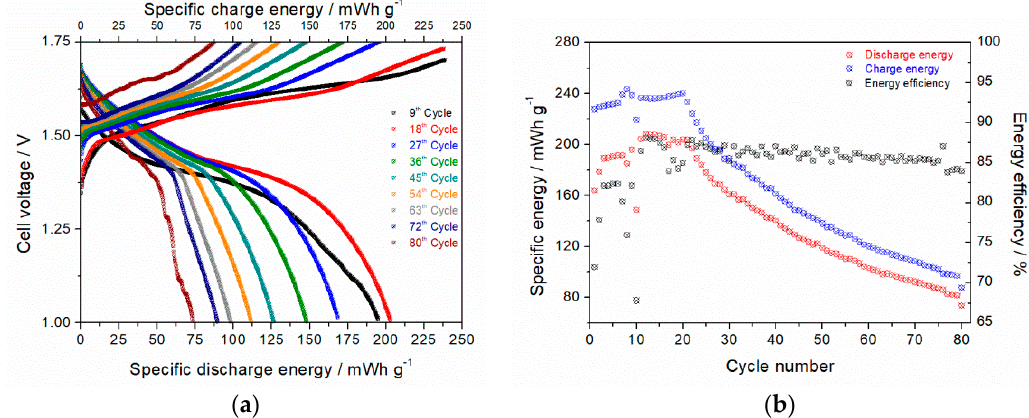
Figure 9: Influence of cycling on charge/discharge behavior of Zn-ion cell at 30 mA g − 1 in 1 M ZnSO 4 with δ -MnO 2 (14 h @ 110 °C in 1.6 M KOH) as cathode and Zn powder as anode.